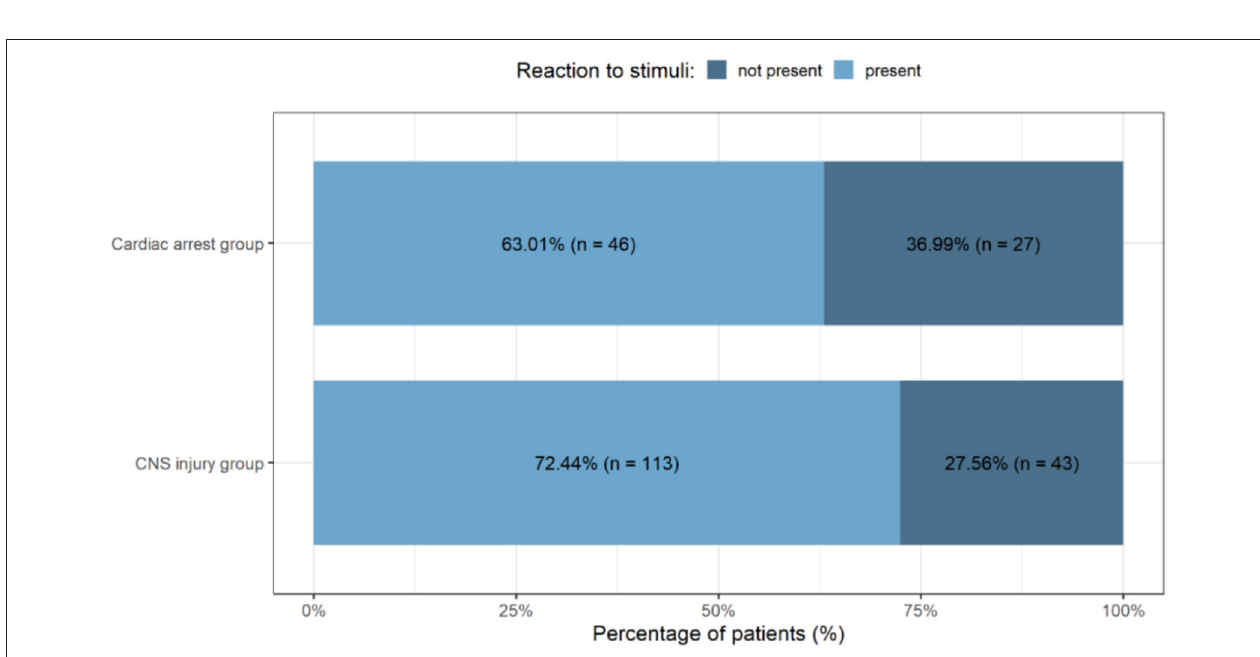
FIGURE 4 | Distribution of ICU length of stay with regard to the type of CNS injury in the DBD group. CNS, Central Nervous System.